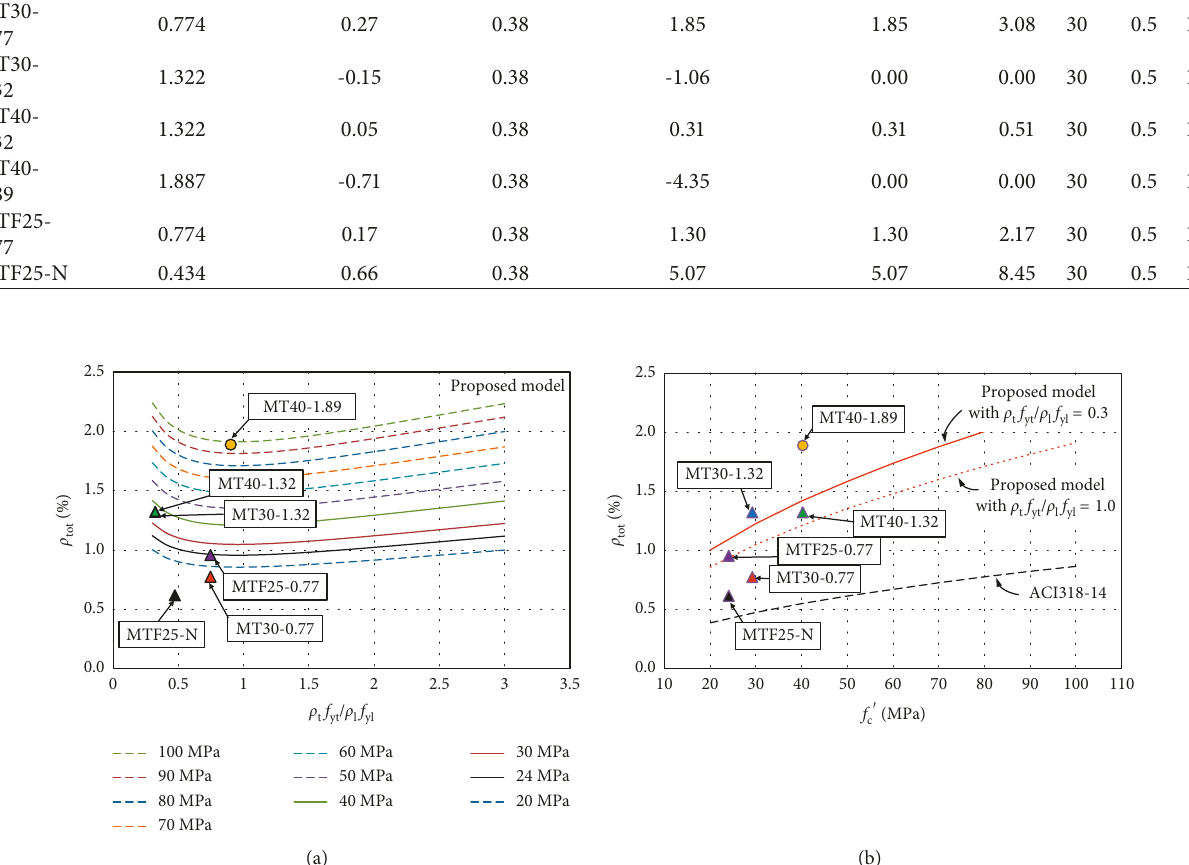
Figure 8: Estimation of reserved strength for torsional members: (a) total reinforcement ratio versus ρ ratio versus f c ′